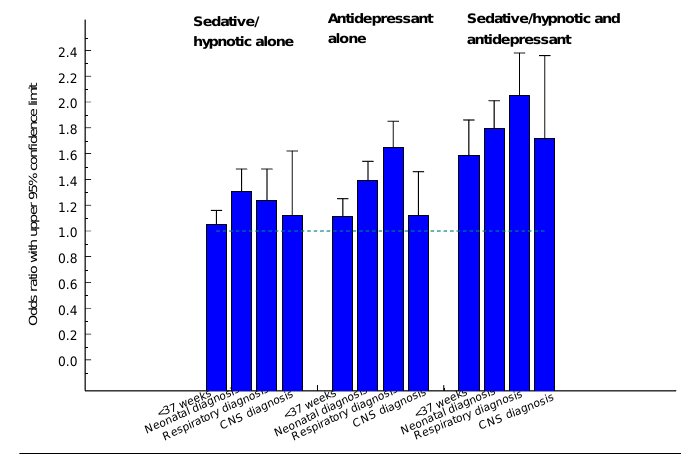
Figure 7. Diagrams showing odds ratios for four neonatal outcomes after maternal use of sedatives/hypnotics or antidepressants alone and after use of a combination of the drugs.